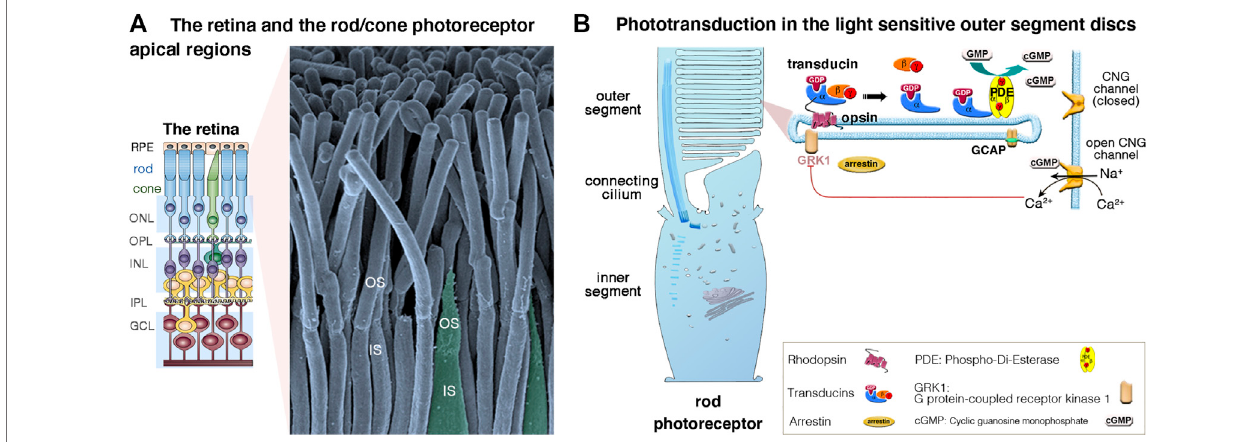
FIGURE 2 | (A , B) The retina, photoreceptor cells and light-sensitive outer segments. (A) The mammalian retina, located at the back of the eye is a laminated, multilayer sensory epithelium, made up of the retinal pigment epithelium (RPE) attached to the different neuronal layers that compose the neuroretina: the outer nuclear layer (ONL), the inner nuclear layer (INL) and the ganglion cell layer (GC), separated by the synaptic Outer plexiform (OPL) and inner plexiform (IPL) layers. The scanning electron micrograph illustrates the apical functional compartments of the rod (nocturnal vision) and cone (diurnal vision) photoreceptor cells, the outer (OS) and the inner (IS) segments, separated by the connecting cilium. (B) Schematic representation of a rod apical region, illustrating the outer segment composed of hundreds to thousands of specialized membrane discs that house the phototransduction cascade machinery. Brie fl y, in absence of light, there is a constant in fl ux of sodium and calcium ions across the cGMP-gated channels (CNG α 1/ β 1) at the outer segment plasma membrane. Incoming light directly activates the light-sensitive opsins, rhodopsin(Rho,rods)andconeopsin,triggeringthephototransductionprocessviatheGproteintransducinsandtheeffectorenzyme,cGMPphosphodiesterase(PDE). The increase of cytosolic cGMP leads to the closure of the CNG channels, photoreceptor cell hyperpolarization, and membrane potential changes leading to graded modulation of glutamate release at the photoreceptor synaptic terminals. Photoresponse is halted upon phosphorylation of opsins by opsin kinases (e.g., GRK1, rods; GRK7, cones) and by arrestin ’ s binding inactivating transducin.